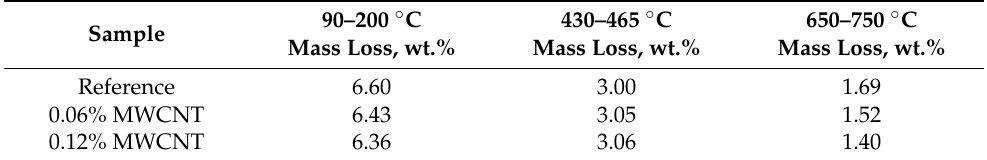
Table 5. Results of thermogravimetric